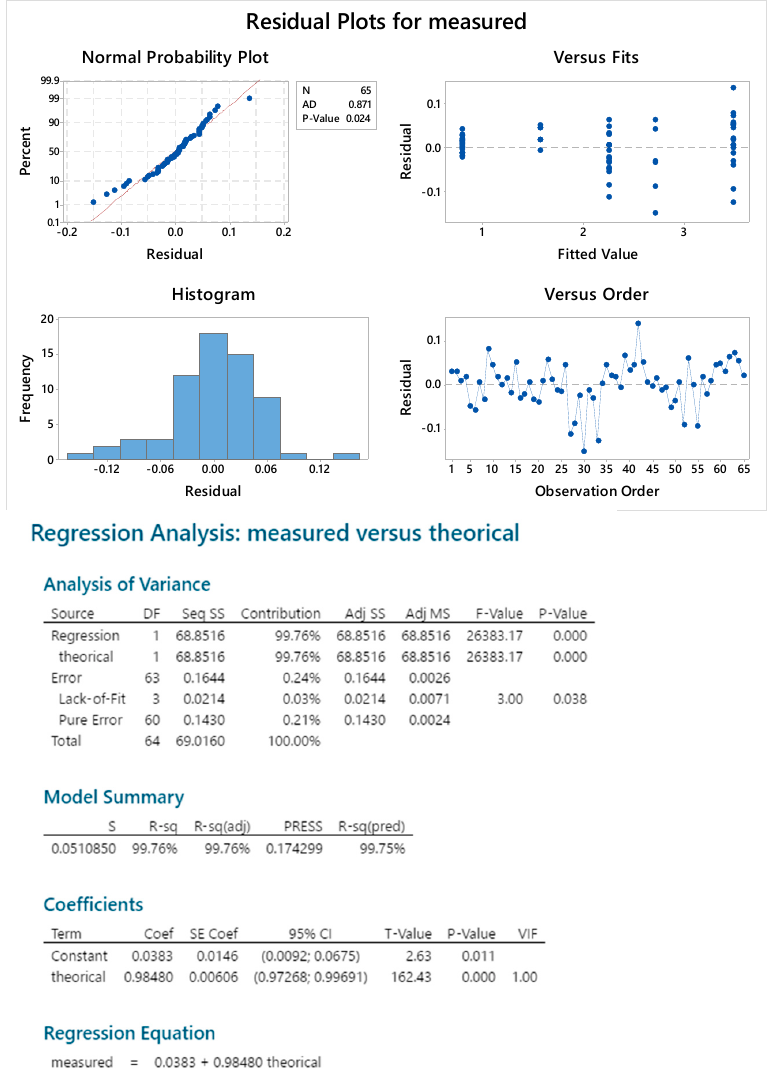
Figure A14. Linear regression analysis for sample Linearity determination for quantification of S. flexneri 6 OAg by HPAEC-PAD (data from six analysis sessions together).